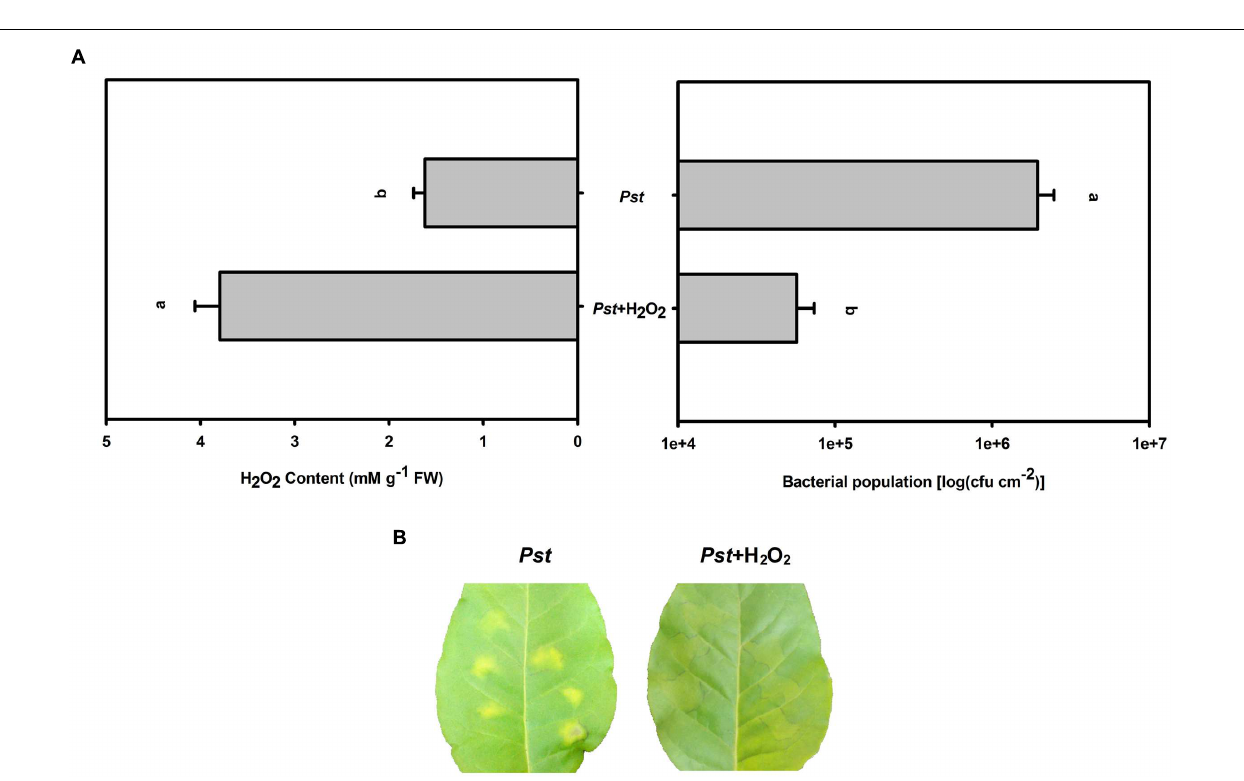
FIGURE 7 | The effect of H 2 O 2 pretreatment on the bacterial population after Pst infection in tobacco leaves under dark conditions. (A) H 2 O 2 accumulation and the Pst population in tobacco leaves after pretreatment with exogenous H 2 O 2 prior to Pst infiltration under dark conditions. Means ± SE of six replicates are presented. Different letters above the columns indicate significant differences between treatments at P < 0.05. (B) Representative images of changes in tobacco leaves pretreated with exogenous H 2 O 2 at 3 dpi under dark conditions.